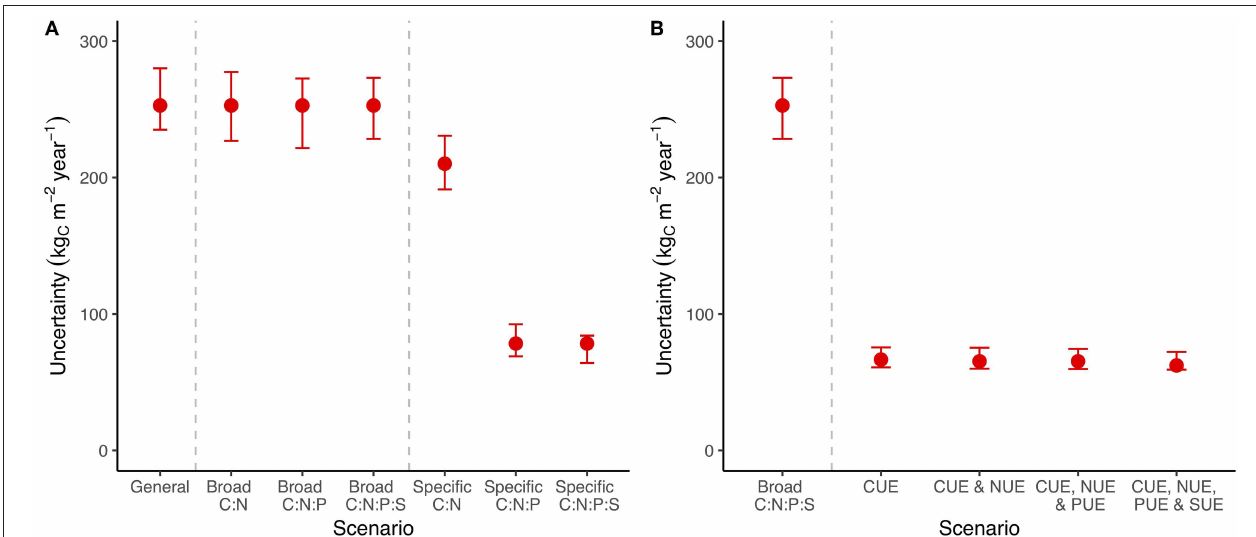
FIGURE 3 | A summary of C cycle uncertainty in the LSD using different amounts of stoichiometry and substrate use efficiency information. (A) The scenarios represent an increasing number of links between element cycles, ranging from entirely independent to linkage between “C:N,” “C:N:P,” and “C:N:P:S.” The general scenario has the widest possible bounds, while still avoiding infinite recycling between pools. Broad scenarios are constrained by a wide range of potential ratios between C and the indicated nutrients, while specific scenarios are constrained to a point estimate of that ratio. (B) Scenarios with CUE, NUE, PUE, and SUE are constrained to a point estimate of C, N, P, and S use efficiency, respectively. Uncertainty is shown for the general model containing all pools and information along with error bars that span the 25th − 75th quantiles of 100 random parameters draws within ± 20% of the base value. Uncertainty is calculated as the sum of the absolute difference in flows between the minimum and maximum flow scenarios. See Figure S2 for N, P, and S.